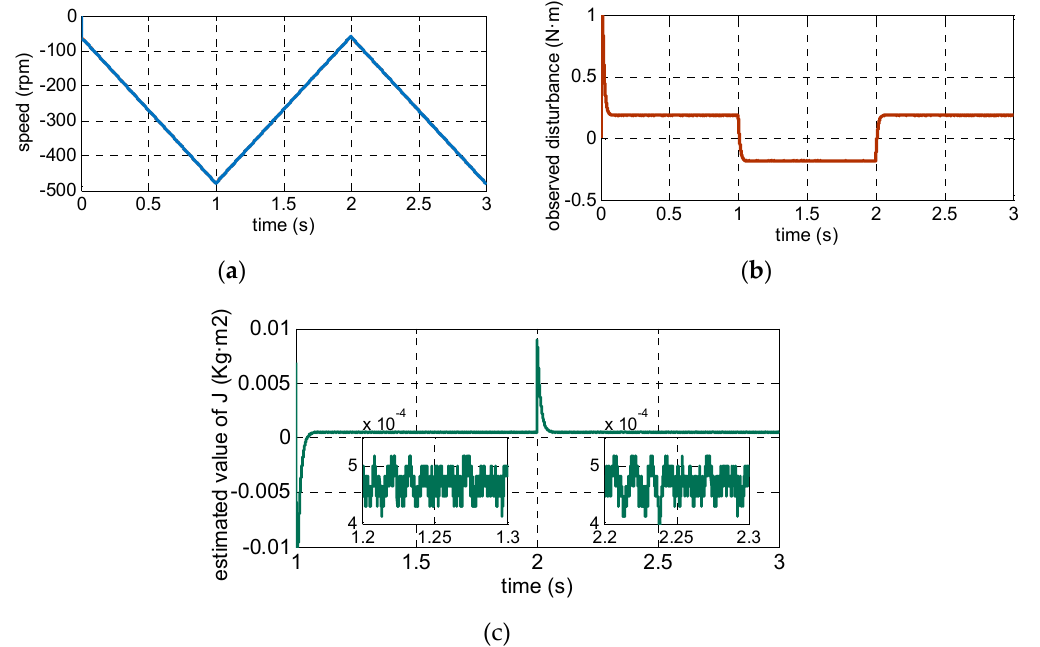
Figure 9. Simulation results under an acceleration of ±420 rpm/s for J 0 = 10 J : ( a ) Measured speed; ( b ) observed disturbance value for parameter mismatch error Δ J ; ( c ) estimated value of parameter J .